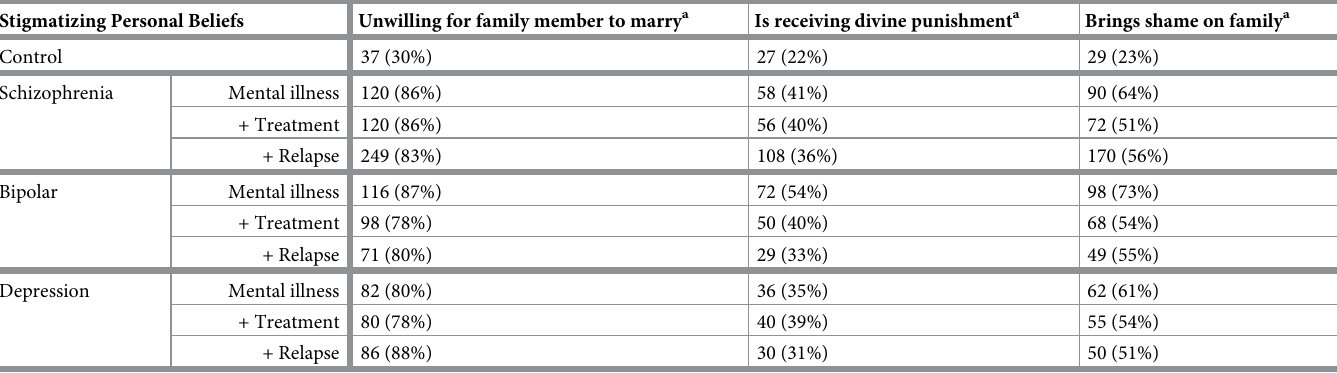
Table 2. Stigmatizing personal beliefs by treatment assignment.